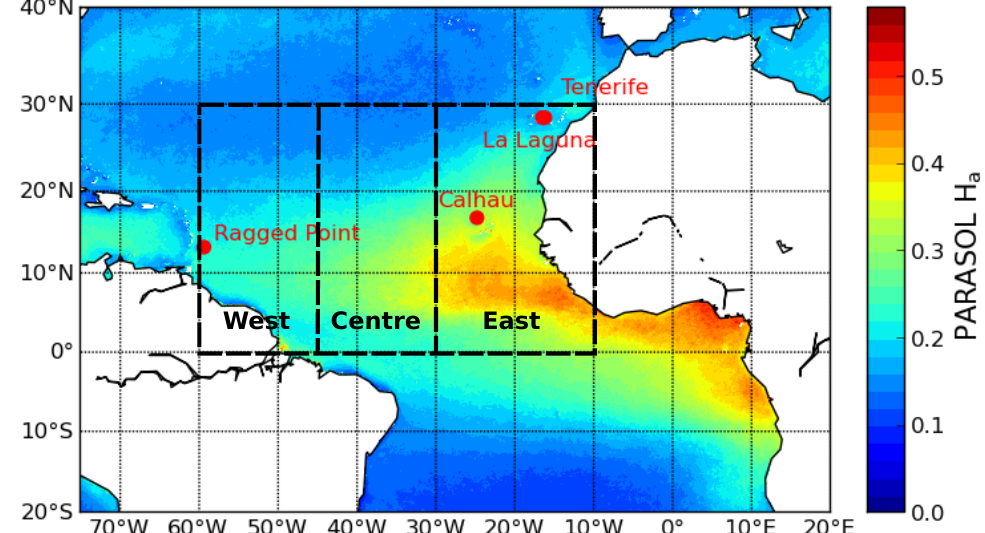
Figure 1. Map of the study area (North Tropical Atlantic Ocean), which is divided into 3 sub-regions: the West zone corresponds to the North East Brazilian zone, the East zone corresponds to the Africa zone and the Centre zone is located between these two zones. The color scale indicates the average value of the aerosol optical depth τ a at 550 nm as derived from the POLAC/PARASOL satellite sensor time-series (2005–2013). The geographical location of the AERONET ground-based stations that are used in this study is also reported in the